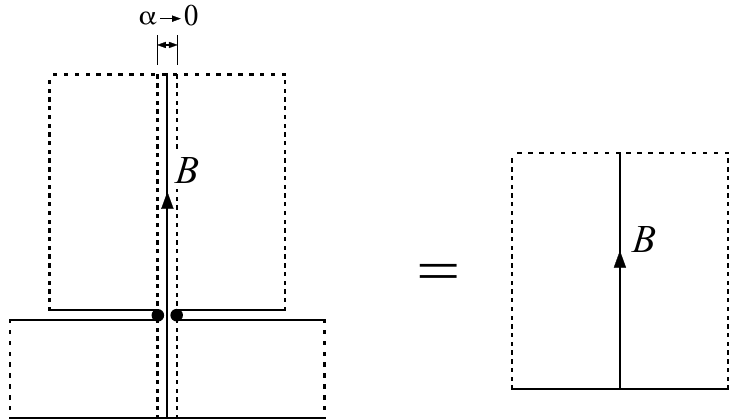
Figure 13 . If the b -ghost contour corresponding to the (cid:12)eld B is squeezed between the slits of a (cid:13)ag and anti-(cid:13)ag state, we can ignore the contribution from integration in the horizontal strip. the right. The second contribution is a vertical line integral inside the horizontal strip connecting Im( z ) = 0 to Im( z ) = i‘ . In the local coordinate (cid:26) on the horizontal strip, this is proportional to b . The third contribution is a contour integral of the b -ghost 0